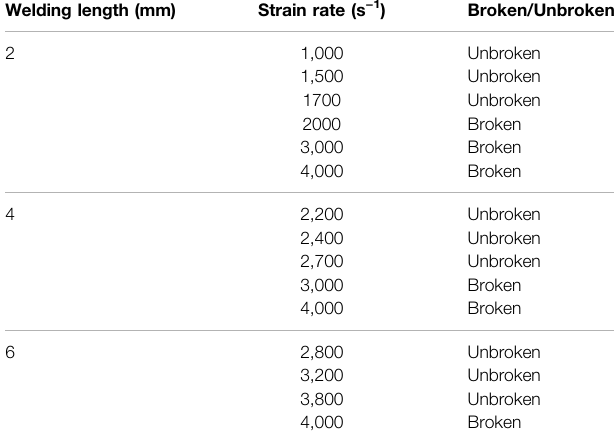
TABLE 2 | Dynamic shear test conditions.